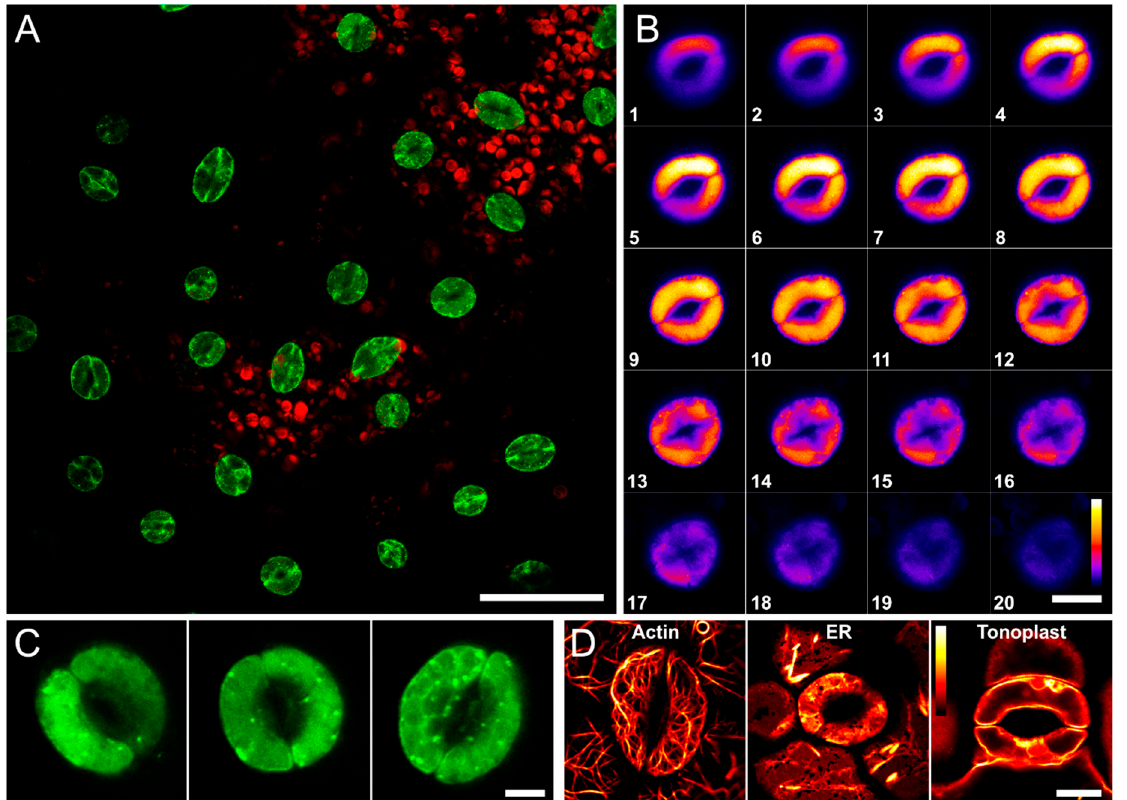
Figure 10. Confocal images of 17d old Arabidopsis rosette leaves (abaxial side) expressing TGG1-GFP, showing GC expression pattern ( A ) and subcellular localization ( B , C ), and 14-day old cotyledons marked with different fluorescent constructs labelling ( D ). ( A ). GCs (TGG1-GFP) shown in green and chloroplasts (autofluorescence) shown in red. Image is a maximum projection of ten optical slices in Z direction (Bar = 50 µm). ( B ). Twenty optical sections through a whole GC from top (1) to bottom (20), showing that the TGG1 fusion protein seem to localize within the GC tonoplasts/vacuoles (Bar = 10 µm) ( C ). High resolution, single sections from individual GC (Bar = 5 µm). ( D ). GCs expressing fluorescent markers for Actin (left), Endoplasmic reticulum (ER) (middle) and Tonoplast (right) (Bar = 10 µm). Actin was visualized by yellow fluorescent protein (YFP) fused to the actin-binding domain of mouse talin (mTalin) [53]. ER was visualized by YFP fused to a synthetic oligonucleotide encoding the ER retention signal HDEL (at C-terminus) and the signal peptide of AtWAK2 ( A. thaliana wall-associated kinase 2; at the N-terminus) (ER-yk, CS16252) [53,54]. Tonoplast was visualized by YFP fused to the C-terminus of γ -TIP, an aquaporin of the vacuolar membrane (vac-yk; CS16258) [53,55]. Seeds of the transgenic Arabidopsis thaliana plants expressing the fluorescent markers for ER and tonoplast were obtained from Nottingham Arabidopsis Stock Centre (NASC).